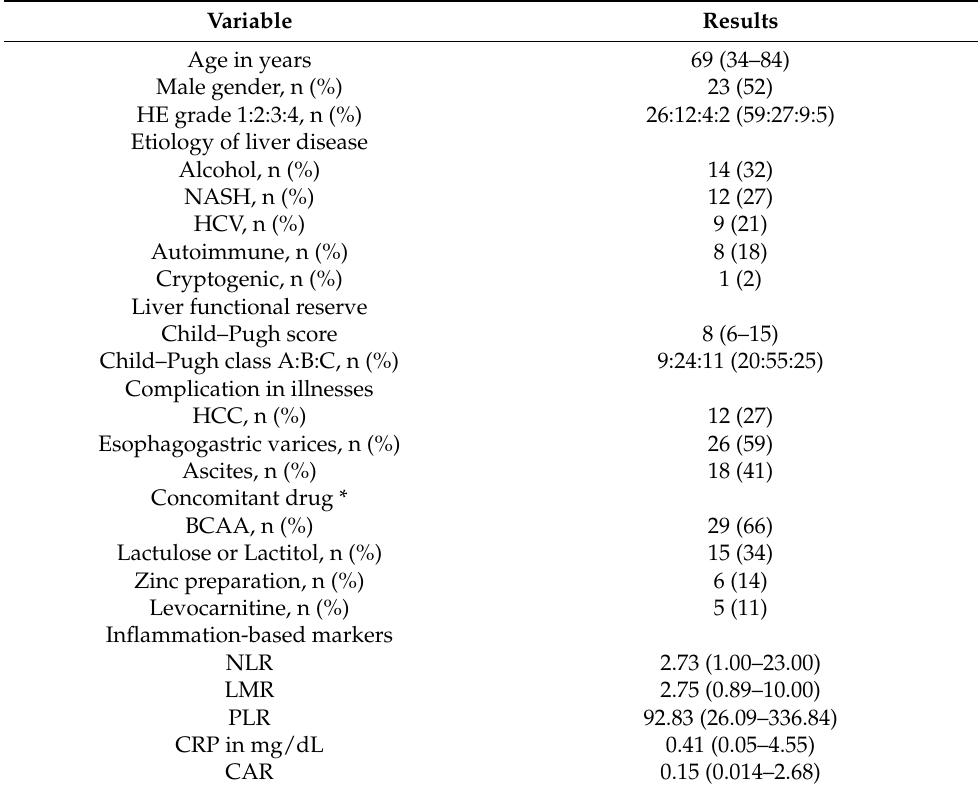
Table 1. Clinical characteristics of the patient at baseline (Examination 1). Variable